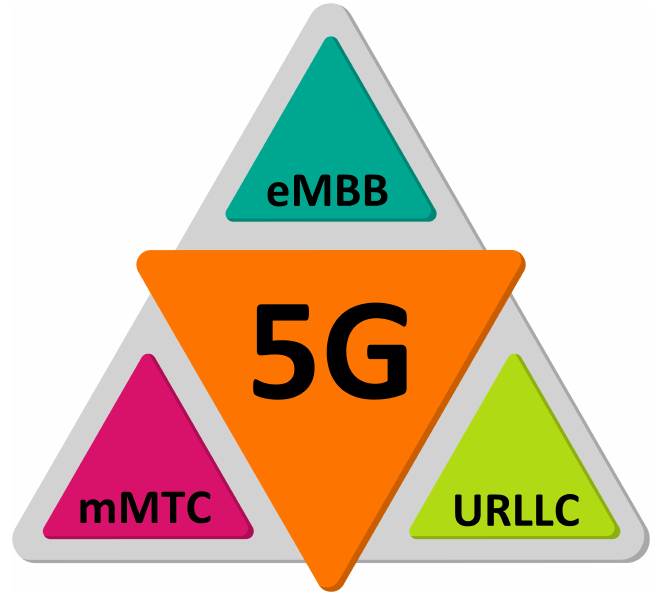
Figure 8. The three generic services offered by 5G.